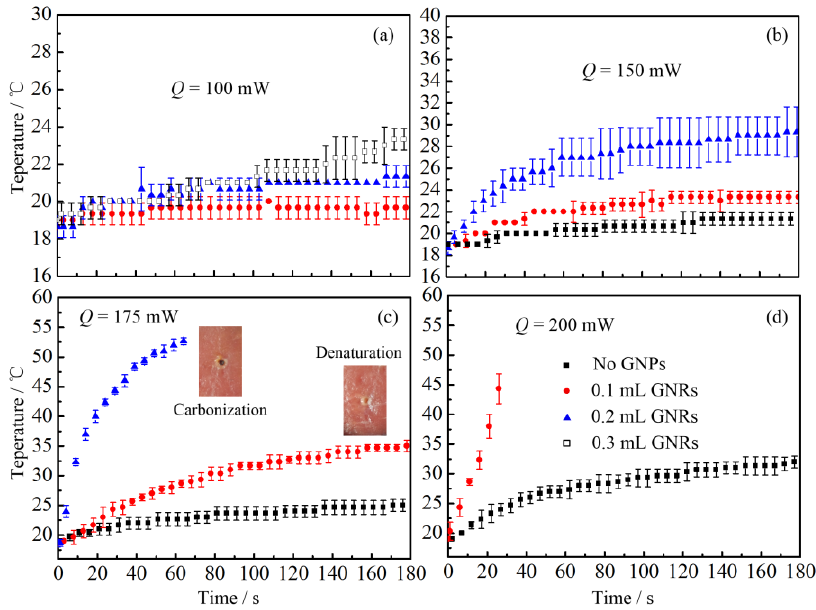
Figure 5. Temperature changes of biological tissue after injecting different amount of GNR solution: